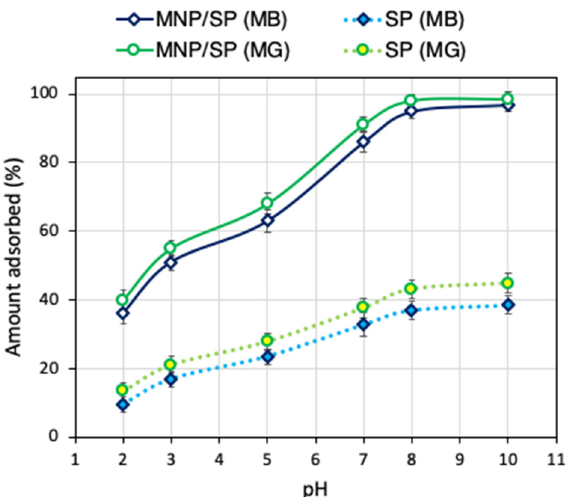
H 2 O 2 -activated serpentine (SP) and iron oxide modified SP (MNP / Figure 4. Effect of pH on adsorption of methylene blue (MB) and malachite green (MG) by H 2 O 2 - activated serpentine (SP) and iron oxide modified SP (MNP/SP).